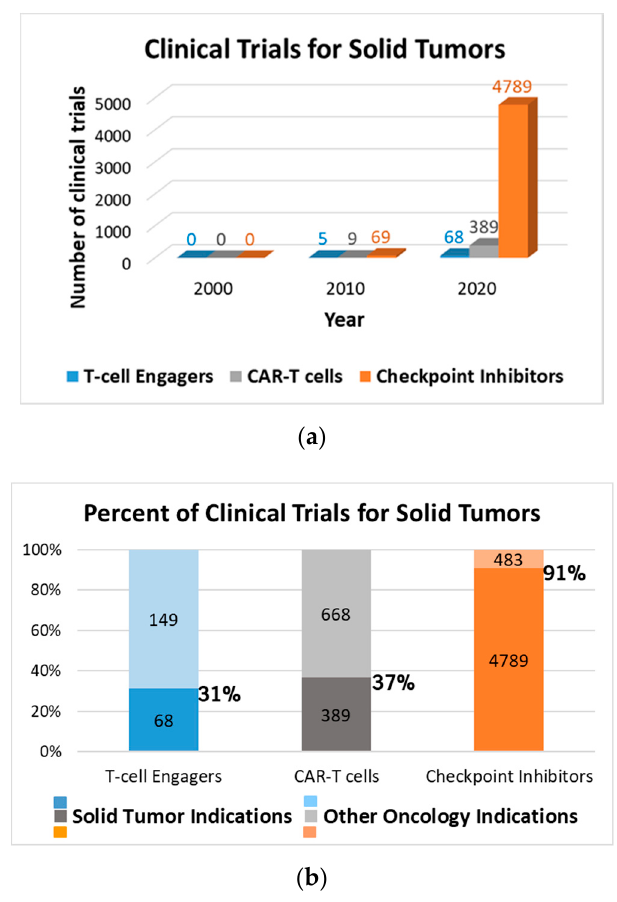
Figure 1. Clinical trials for solid tumors: ( a ) Comparison of number of clinical trials with TcEs, CAR-Ts and CPIs for solid tumors over time (2000, 2010, 2020). The numbers are from a search in the Citeline database by: (1) Mechanism of action: “CD3 agonism” for TcEs and “immune Checkpoint Inhibitors” for CPIs; (2) Therapeutic area: in both cases, “Oncology”, and as sub-categories all listed solid tumor indications; (3) Therapeutic modality: monoclonal antibodies and all similar classes (chimeric, humanized, human); (4) Timeframe: before year 2000, between years 2000 and 2010, and in year 2020; ( b ) Percent of clinical trials for solid tumor indications vs. all oncology indications for each of the three therapeutic modalities. The numbers inside the columns correspond to the number of clinical trials. The percent number on the side of each column indicates the percent of clinical trials for solid tumor indications vs. for all oncology indications with each of these therapeutic modalities.